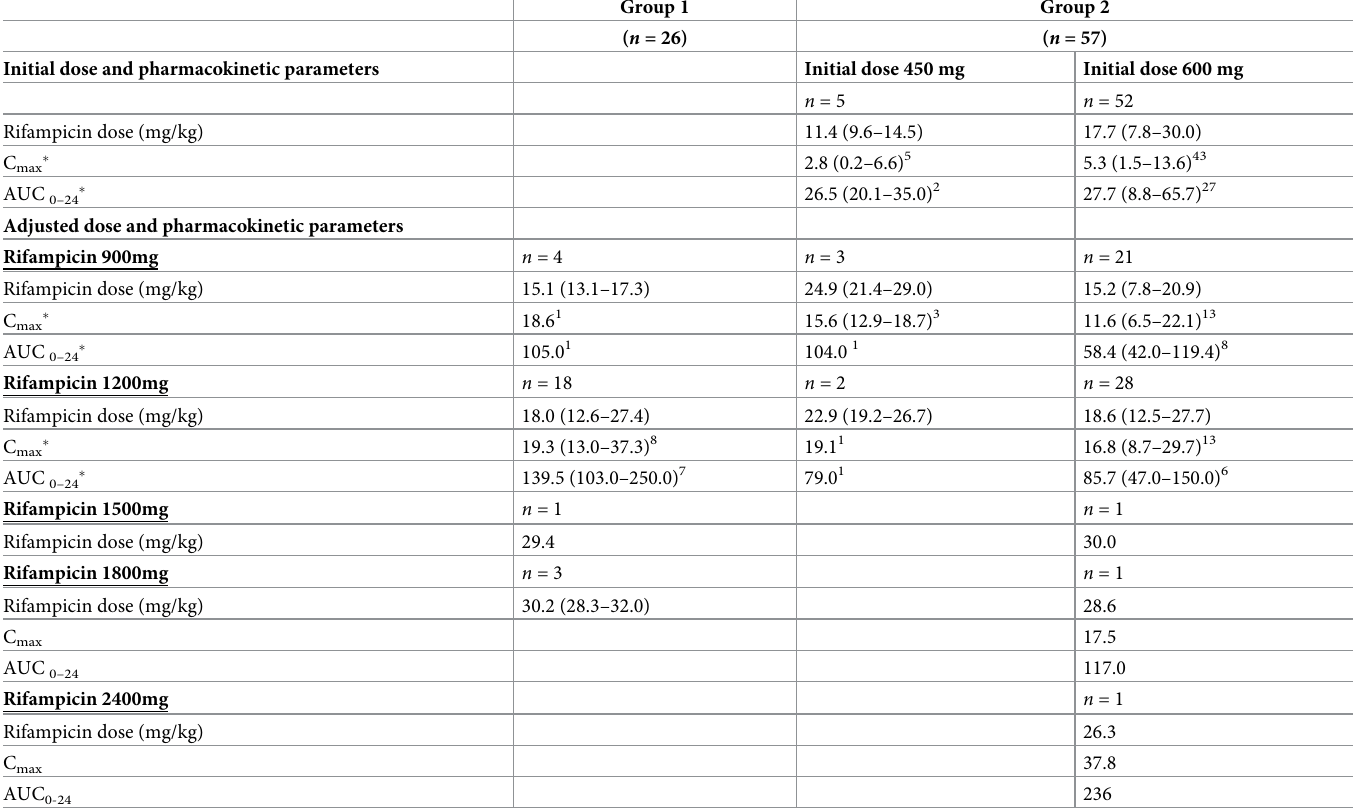
Group 1: initial high-dose rifampicin due to severe illness. Group 2: proven low plasma concentrations on standard dose with the dose adjustments made guided by therapeutic drug monitoring. Results of rifampicin dose per kg bodyweight are expressed as mean (minimum–maximum) and C max and AUC 0-24 are presented as geometric mean (minimum– maximum). � Data available in number of patients. AUC 0-24 , area under the 24-h concentration-time curve; C max , peak plasma concentration. Target C max range: � 8 mg/L and AUC 0-24 of 41.1 mg/L, based on